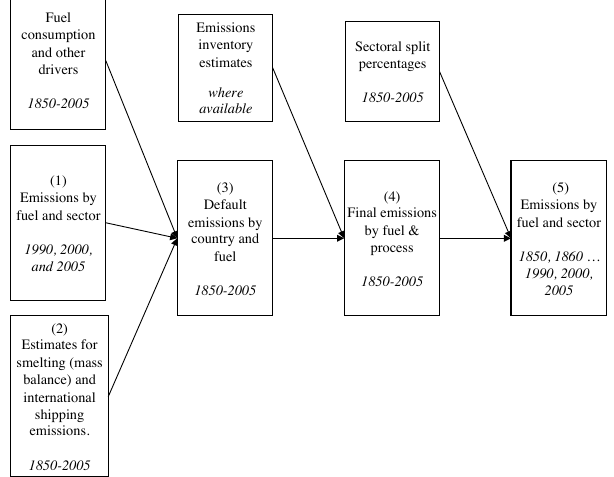
Fig. 1. Calculation summary. The key steps in the calculation are: (1) development of an inventory by sector and fuel for three key years, (2) development of detailed estimates for smelting and inter- national shipping, (3) calculation of a default set of emissions by interpolating emissions factors from the key years, (4) calculation of final annual emissions values by fuel that match inventory values, and (5) estimate sectoral